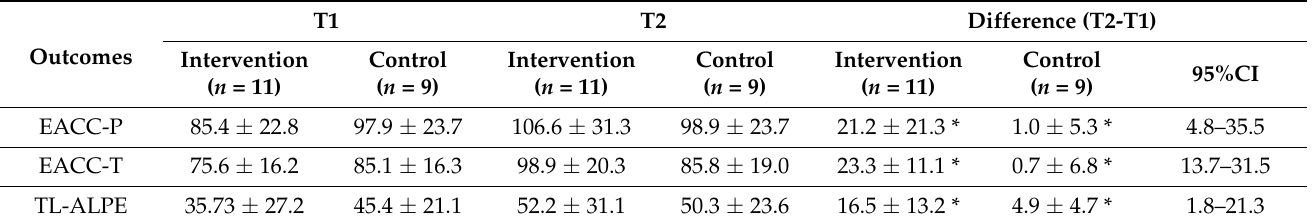
Table 3. Pre-intervention (T1) and post-intervention (T2) results of secondary outcomes (EACC and